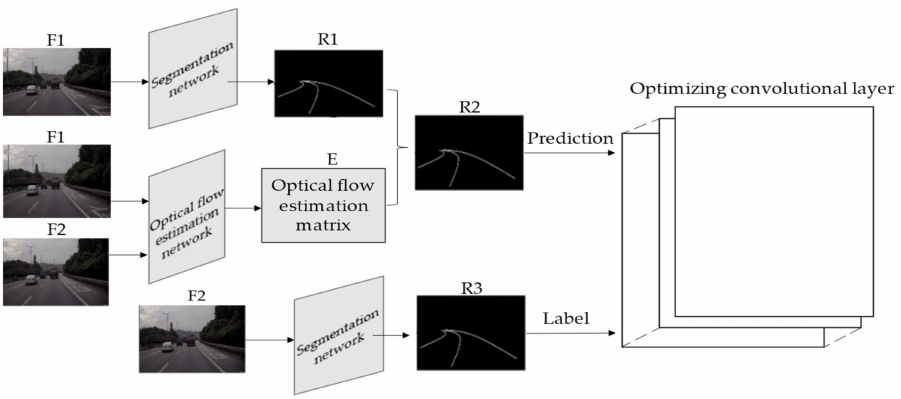
Figure 8. Training process of optimizing convolutional layer.